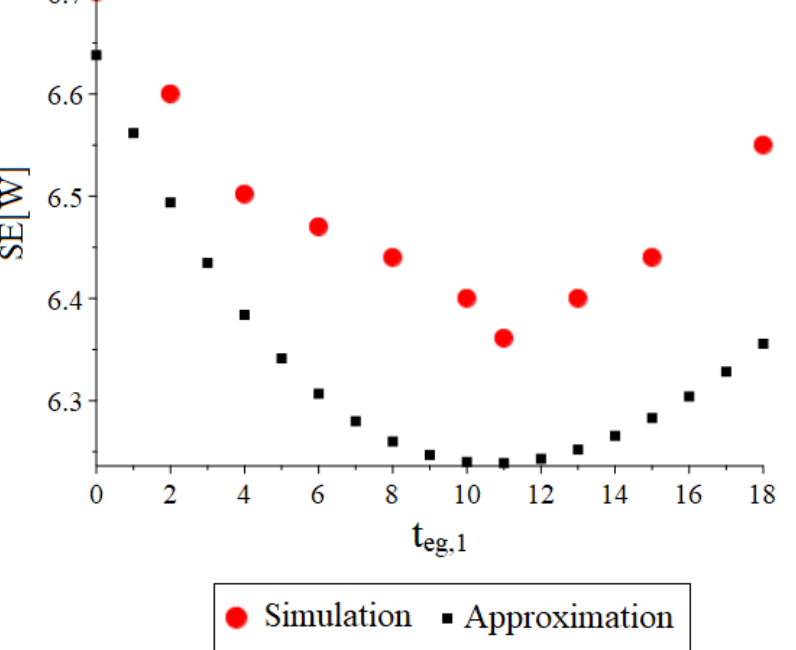
Figure 9. Expected waiting time as a function of t eg ,1 according to